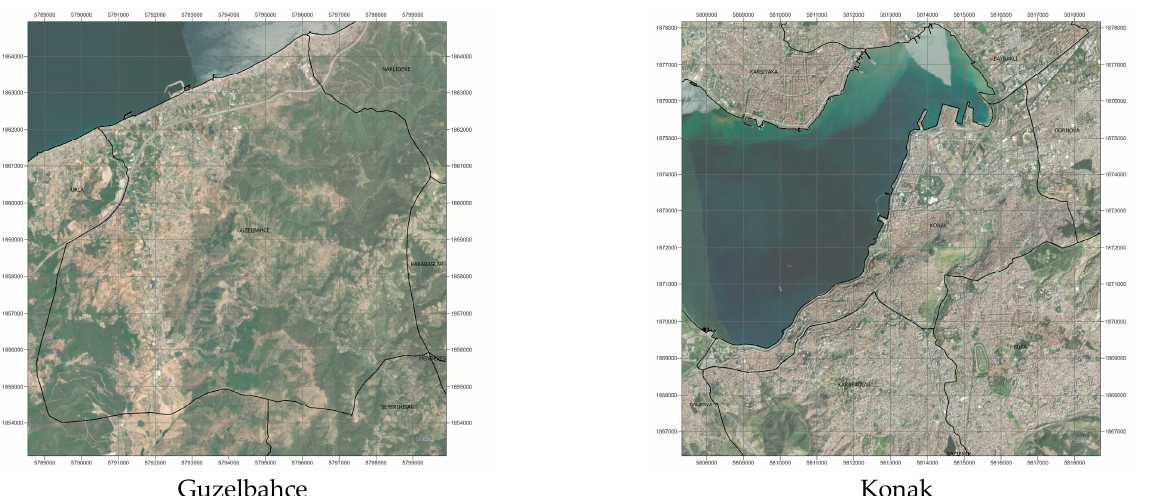
Figure 6. Izmir’s neighborhoods. Guzelbahce ( left ) and Konak ( right ). Source: Author’s elabora- tion.